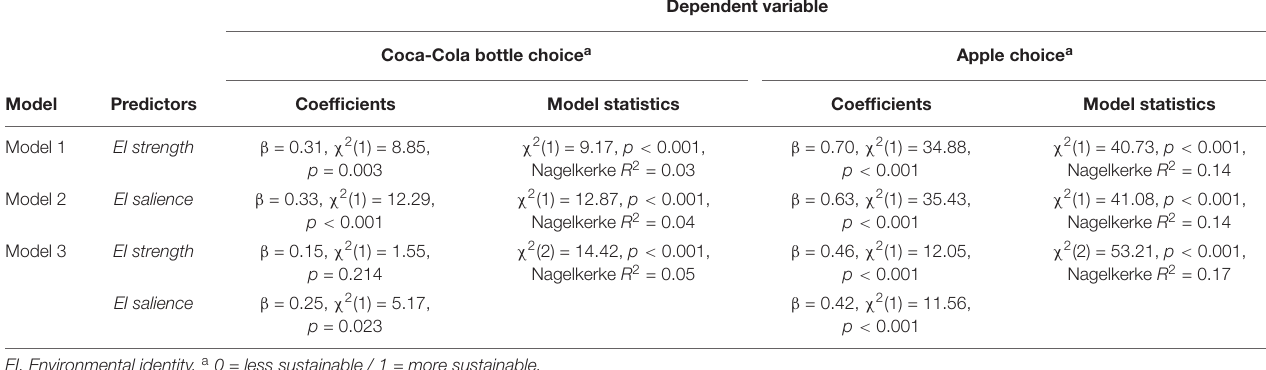
TABLE 3 | Logistic regression models (Study 2).